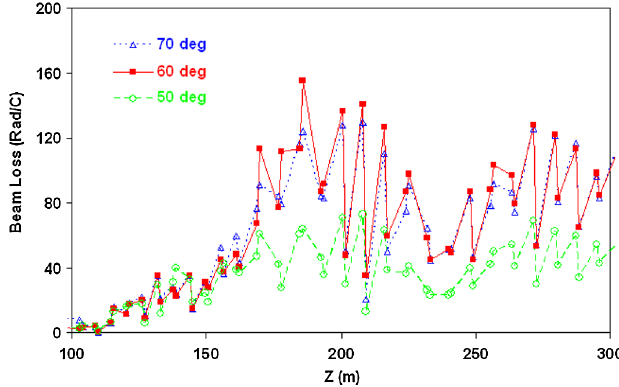
FIG. 10. (Color) Linac beam loss monitor measured SCL losses for the zero-current phase advance 50 (cid:1) , 60 (cid:1) and 70 (cid:1) lattices.